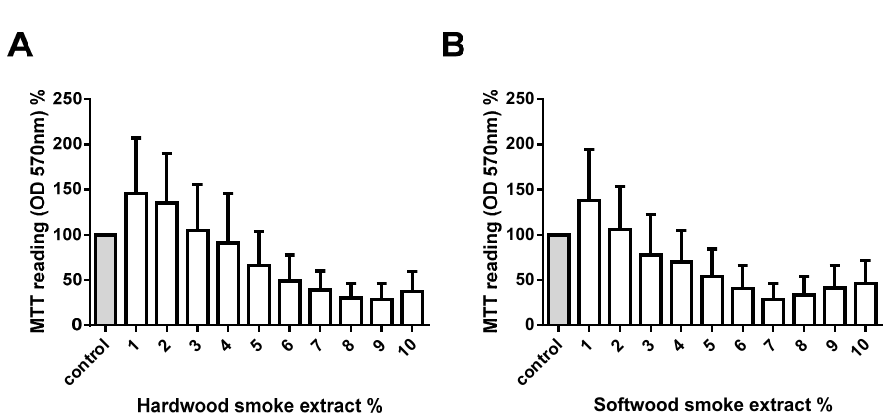
Figure 1. Measurement of cell viability with different hardwood and softwood smoke extract concentrations. Human primary lung fibroblasts ( n = 5) were stimulated with hardwood ( A ) and softwood ( B ) smoke extract (1%–10%) in 0.1% FBS/DMEM. Cell viability was measured using MTT assay at 24 h after stimulation. Data expressed as the percent of unstimulated fibroblasts and bars represent mean ± SEM. Statistical analysis was executed using one-way ANOVA with Tukey’s post-test. No significant differences were found.